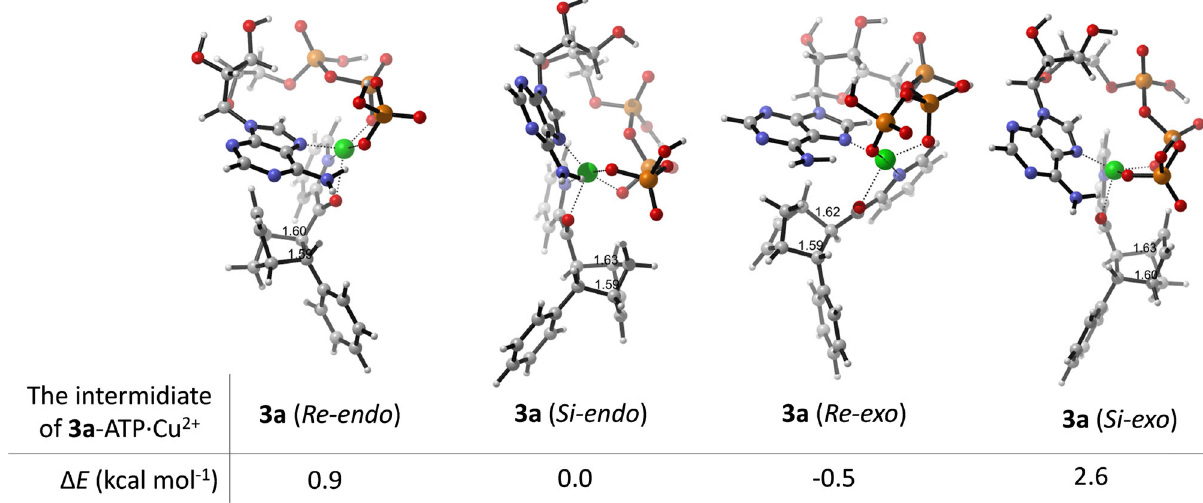
Supplementary Fig. 24. The intermediates of 3a -ATP ⋅ Cu 2 + and their relative electronic energies ( Δ E).